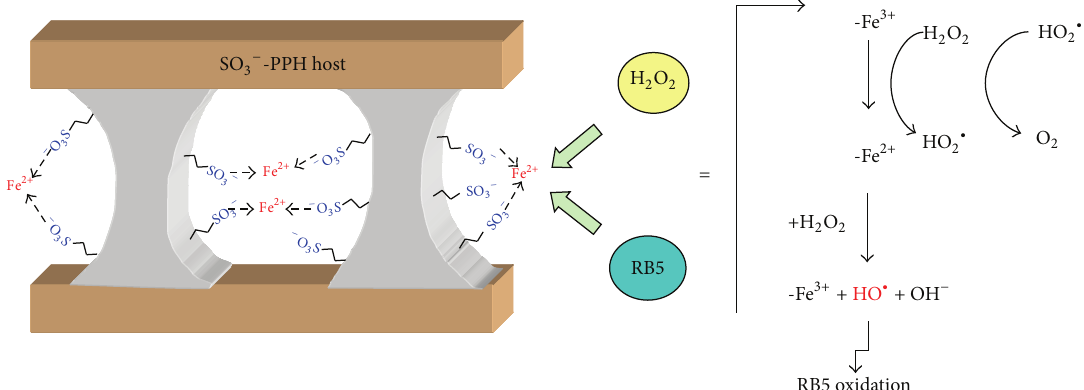
Figure 3: Mechanistic representation of reactions possible involved in heterogeneous Fenton-like catalysed by Fe-PPH.